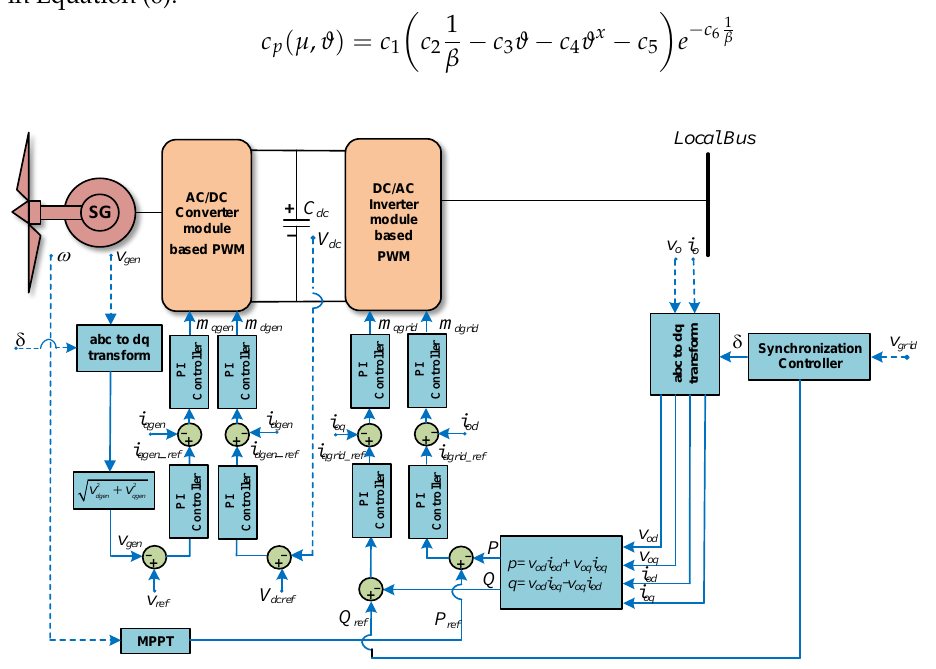
Figure 3. Schematic diagram of WECS based on PMSG.